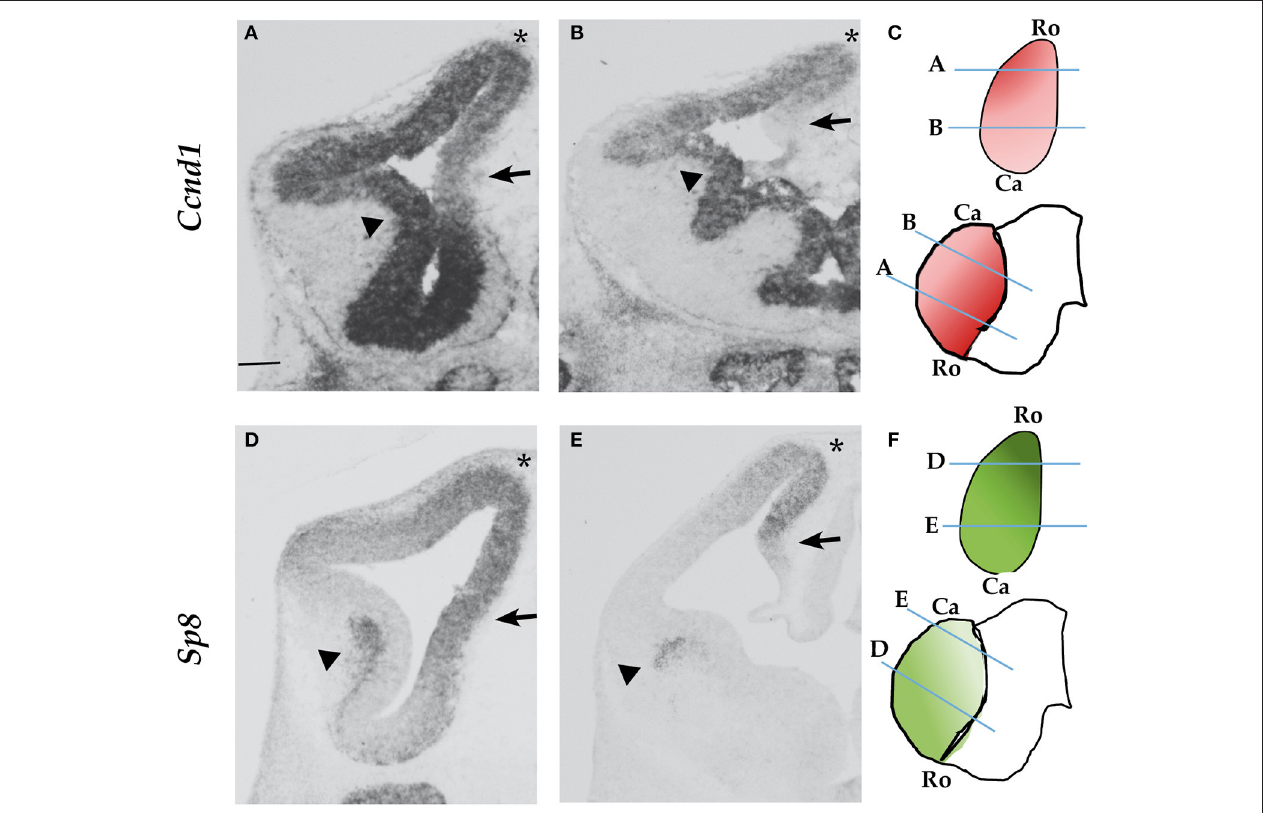
FIGURE 1 | Ccnd1 and Sp8 expression patterns at E12.5. ISH performed on E12.5 mouse forebrain coronal sections. Panels (A,B) show Ccnd1 mRNA expression; Panels (D,E) indicate Sp8 mRNA expression. Schematic of Ccnd1 (C) and Sp8 (F) gradients of expression are indicated along with the positions of sections shown in (A–D) . Panels (A,D) represent sections at the rostral level, while Panels (B,E) represent sections at the caudal level. Arrows point to the medial pallium; arrowheads indicate the VZ (A,B) or the SVZ of the LGE (D,E) . The asterisk indicates the dorsal pallium. Bar in panel (A) is 200 µ m. Ro, rostral; Ca,